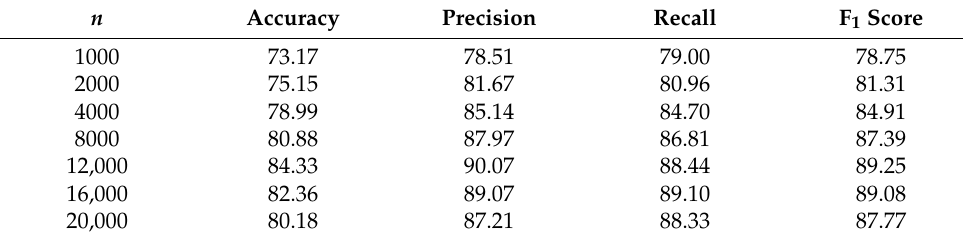
Table 4. Comparison of the multiclassification metrics at different sample